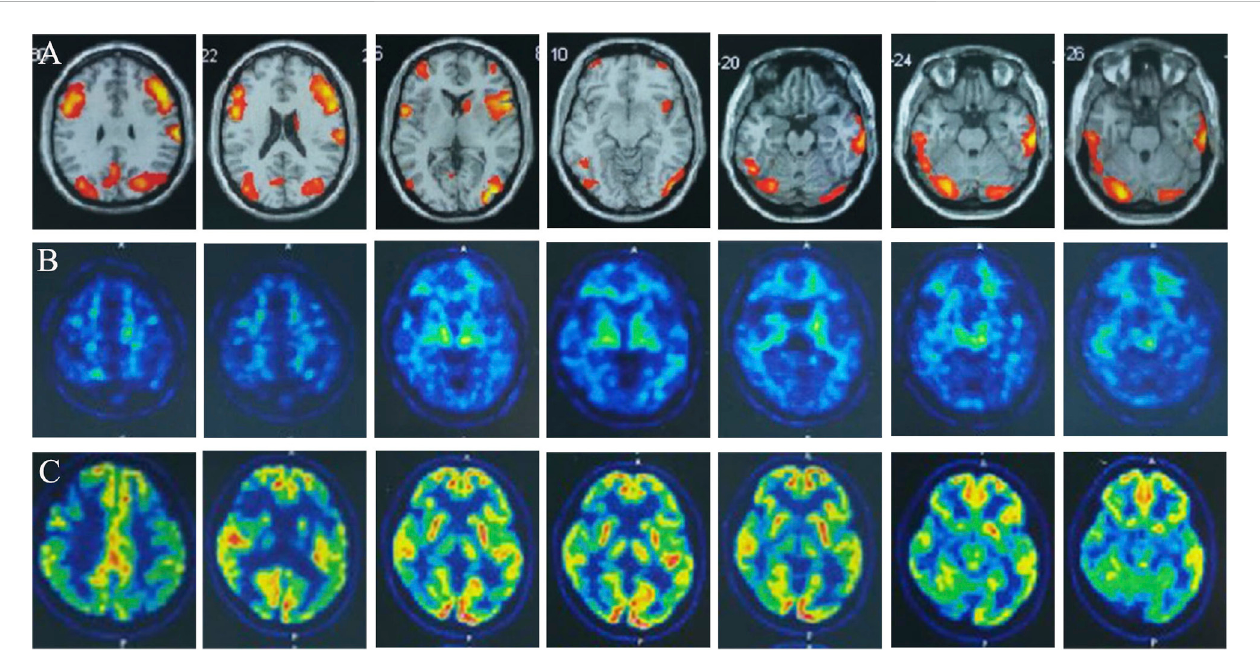
FIGURE 2 Multimodality molecular imaging of the patient: (A) Multimodal molecular imaging of 18- fl uoro-2-deoxy-D-glucose positron emission tomography ( 18 F-FDG PET-CT) results suggested hypometabolism in dorsolateral frontal cortex, dorsolateral parietal cortex, bilateral precuneus, lateral of right temporal lobeandrightoccipitallobe,andrightcaudatenucleus. (B) 11-carbon-Pittsburghpositronemissiontomography( 11 C-PIBPET-CT)showednoamyloidplaque deposition in the brain. (C) 18- fl uoro-S16-positron emission tomography ( 18 F-Flortaucipir-tau PET-CT) showed tau deposition in bilateral thalamus, caudate nucleus, midbrain, pons, and bilateral medial temporal